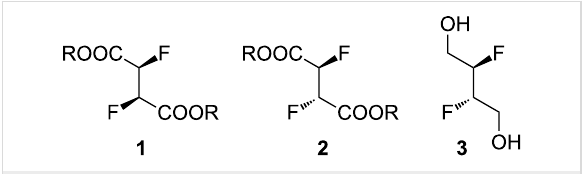
Figure 1: Vicinal difluoride containing building